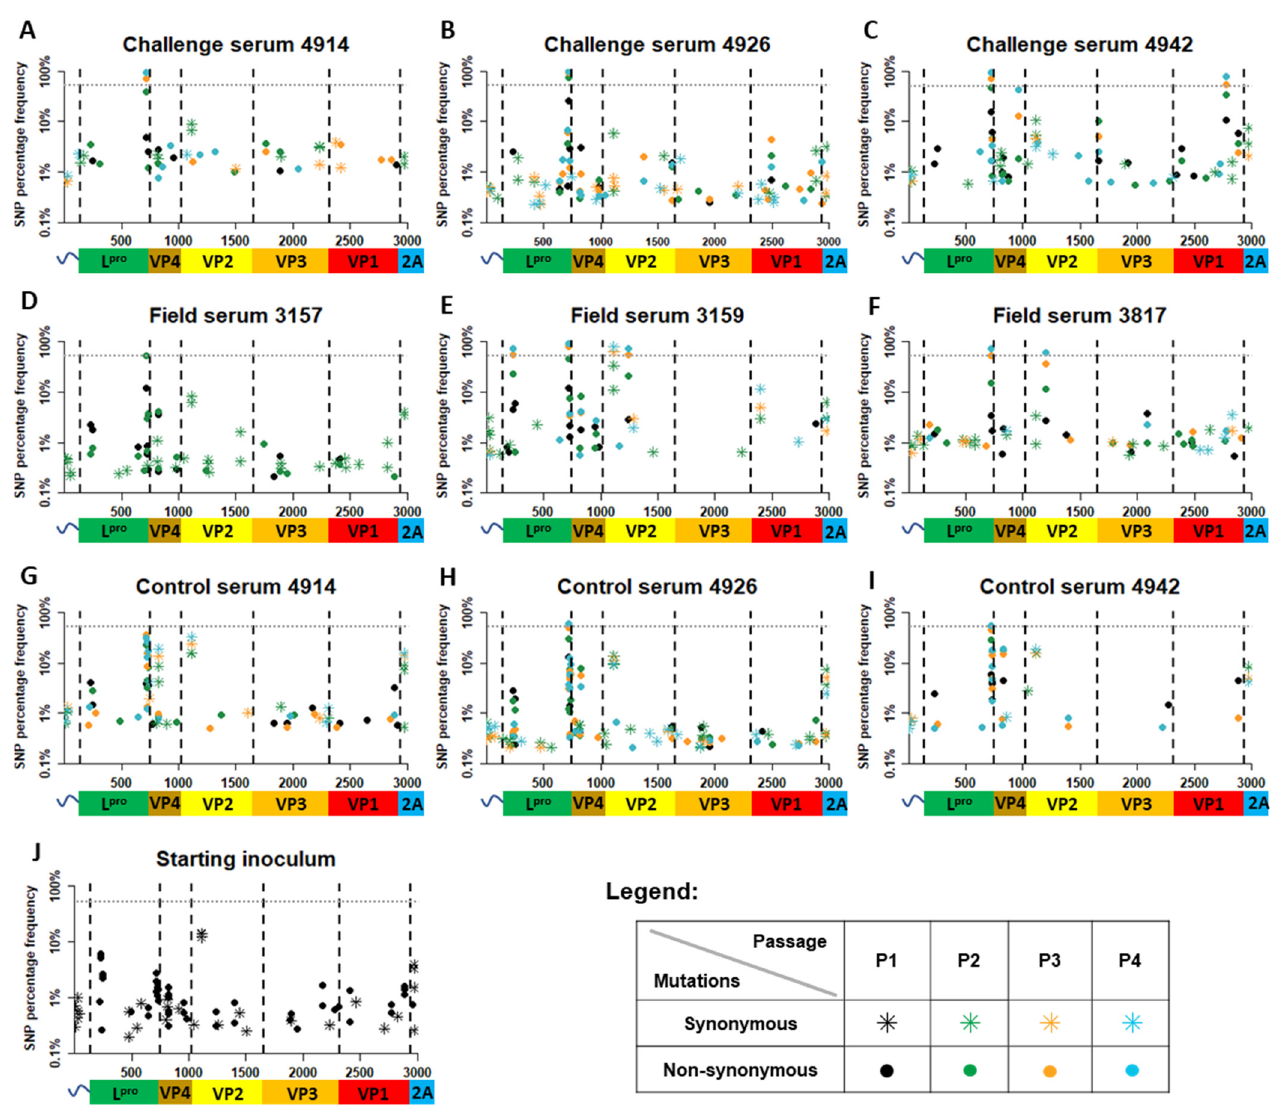
Figure 3. Mutations identified in virus populations passaged in the presence of FMDV sub-neutralising sera and in control viruses. Viral populations which were passaged in presence of Field sera ( A – C ), Challenge sera ( D – F ) or Control sera ( G – I ), as was described for Figure 2, were sequenced using Illumina MiSeq. All mutations which were detected above error threshold and in both sequencing duplicates (as specified in Material and Methods) (except Field Serum 3817, for which one technical replicate failed to sequence) were mapped along the amplicon, which spanned from the terminal section of the 5 ′ UTR to the region encoding the 2A protein. Synonymous mutations are represented by asterisks, while non-synonymous mutations are represented by filled circles. Both symbols were colour-coded according to the passage, with black, green, orange and turquoise representing P1, P2, P3 and P4, respectively. Starting inoculum ( J ), i.e., IRN/22/2015 isolate adapted to LFBK- α V β 6 cells over five passages, was sequenced with each individual MiSeq sequencing run ( n = 3). Mutations detected on all three MiSeq runs were included, with synonymous mutations marked with an asterisk and non-synonymous mutations marked with a filled circle. The grey dashed horizontal line indicates the 50% threshold used to determine consensus